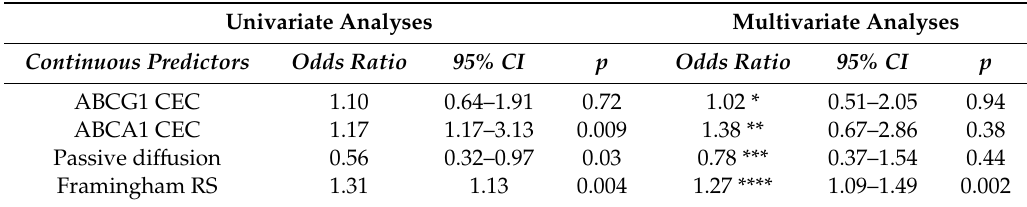
Table 3. Logistic regression analyses for CAC lesion